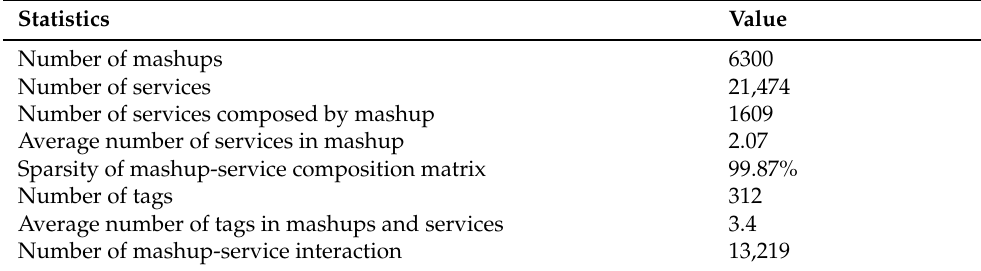
Table 1. Dataset